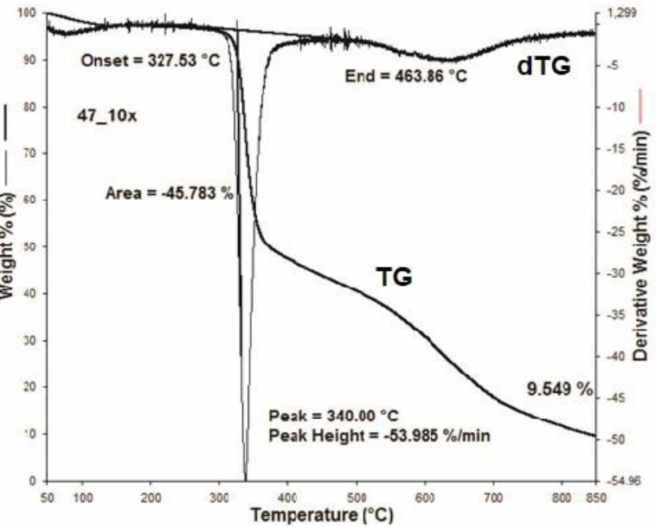
Figure 5. Thermogravimetric analysis of 47_10x sample: TG curve, dTG